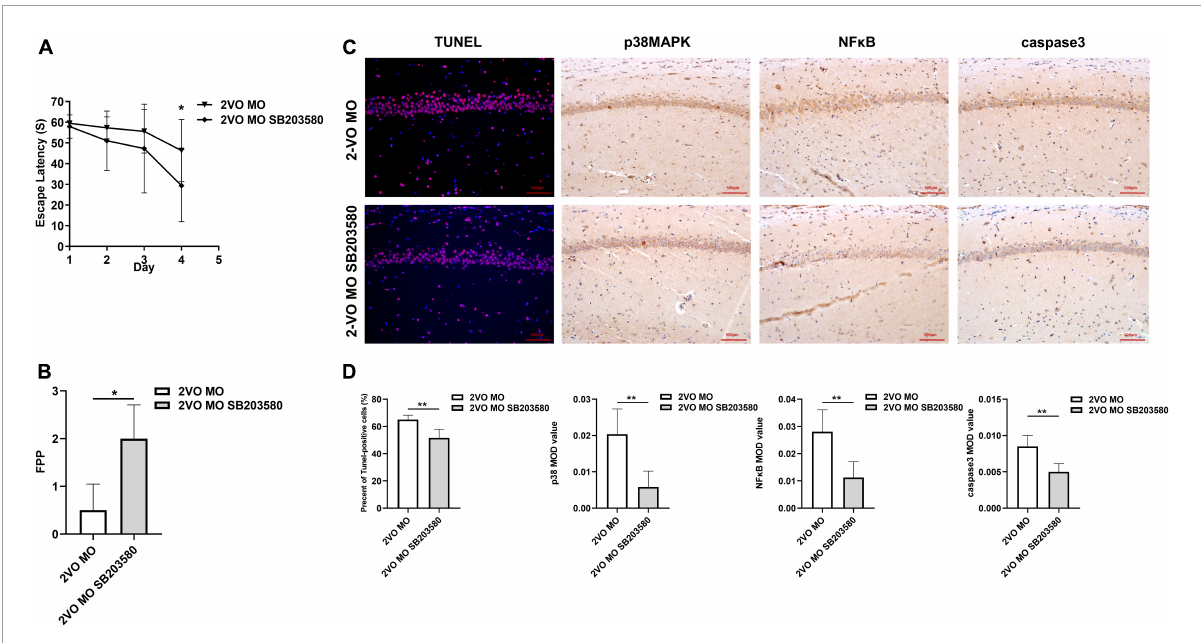
FIGURE8 Effects of SB203580 on cognitive impairment and apoptosis of hippocampal neurons in 2-VO rats following molar loss. (A) Changes in escape latency in learning trial (* p < 0.05). (B) The frequency of passing the platform (FPP) in each group (* p < 0.05). (C,D) TUNEL staining of CA1 region of rat hippocampus cell nuclei (blue), the red spots represent TUNEL-positive cells ( × 200, the positive rate is expressed as mean ± SD, n = 6, ** p < 0.01). IHC staining showed the expression of p38MAPK, caspase3, and NF κ B (IHC, × 200, n = 6, MOD values are expressed as mean ± SD, ** p <